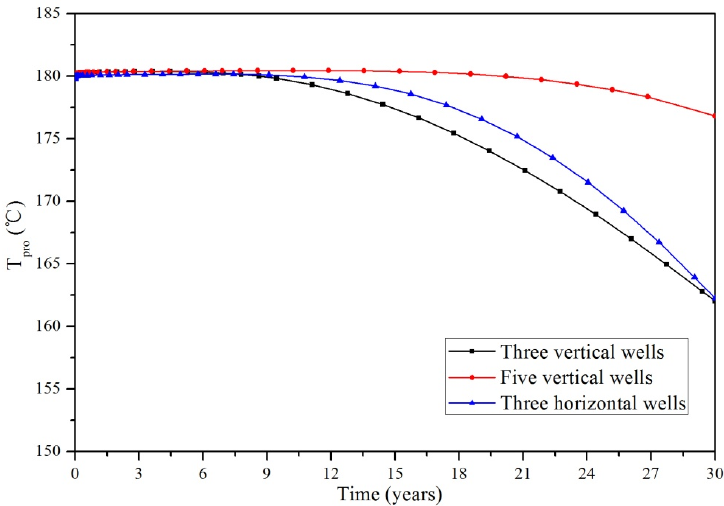
Figure 6. The change of production temperature versus time under different well layouts. In the calculation of the electric power in Equation (4) at Gonghe Basin geothermal field, the heat rejection temperature is T 0 = 4.1 °C = 277.25 K [3 7 ]. Figure 7 shows the change of the electric power versus time under different well layouts. The electric power gradu- ally declines from 11.13 to 8.81 MW via three vertical wells, and it declines from 11.33 MW to 10.92 MW during the 30 years via five vertical wells. The electric power gradually de- clines from 17.36 to 13.79 MW via three horizontal wells during the 30 years. Figure 7 shows that for reservoirs of the same size of 1000 × 1000 × 500 m, the electric power via three horizontal wells is higher than that via five vertical wells, and the electric power via five vertical wells is higher than that via three vertical wells. Based on Equation (4), main factors influencing the electric power is water production rate q and the production tem- perature T pro . As stated above, because the sequence of water production rate is three hor- izontal wells > five vertical wells > three vertical wells, the production temperature differ- ence is very small, thus the electric power is mainly determined by the water production rate, and the three horizontal well system obtains highest electric power and the three vertical well system obtains lowest electric power. Figure 7. The change of electric power versus time under different well layouts.